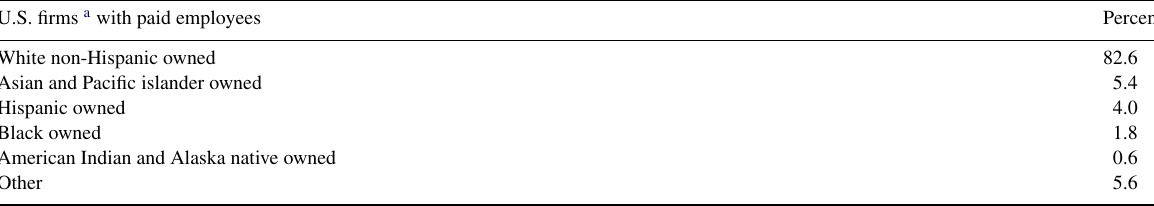
Table 1 1997 U.S. firm ownership by race